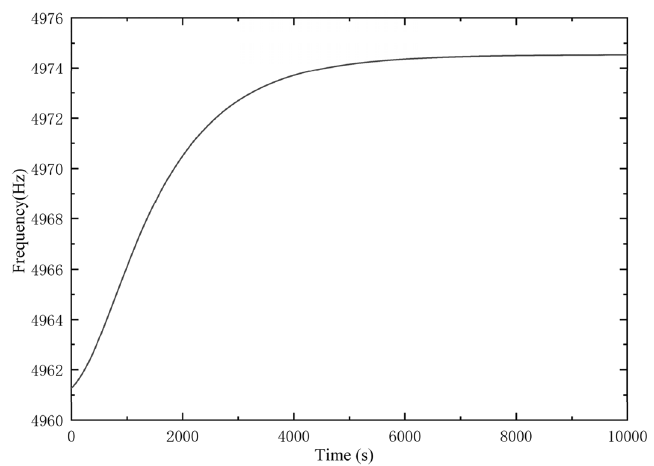
Figure 7. Gyro resonant